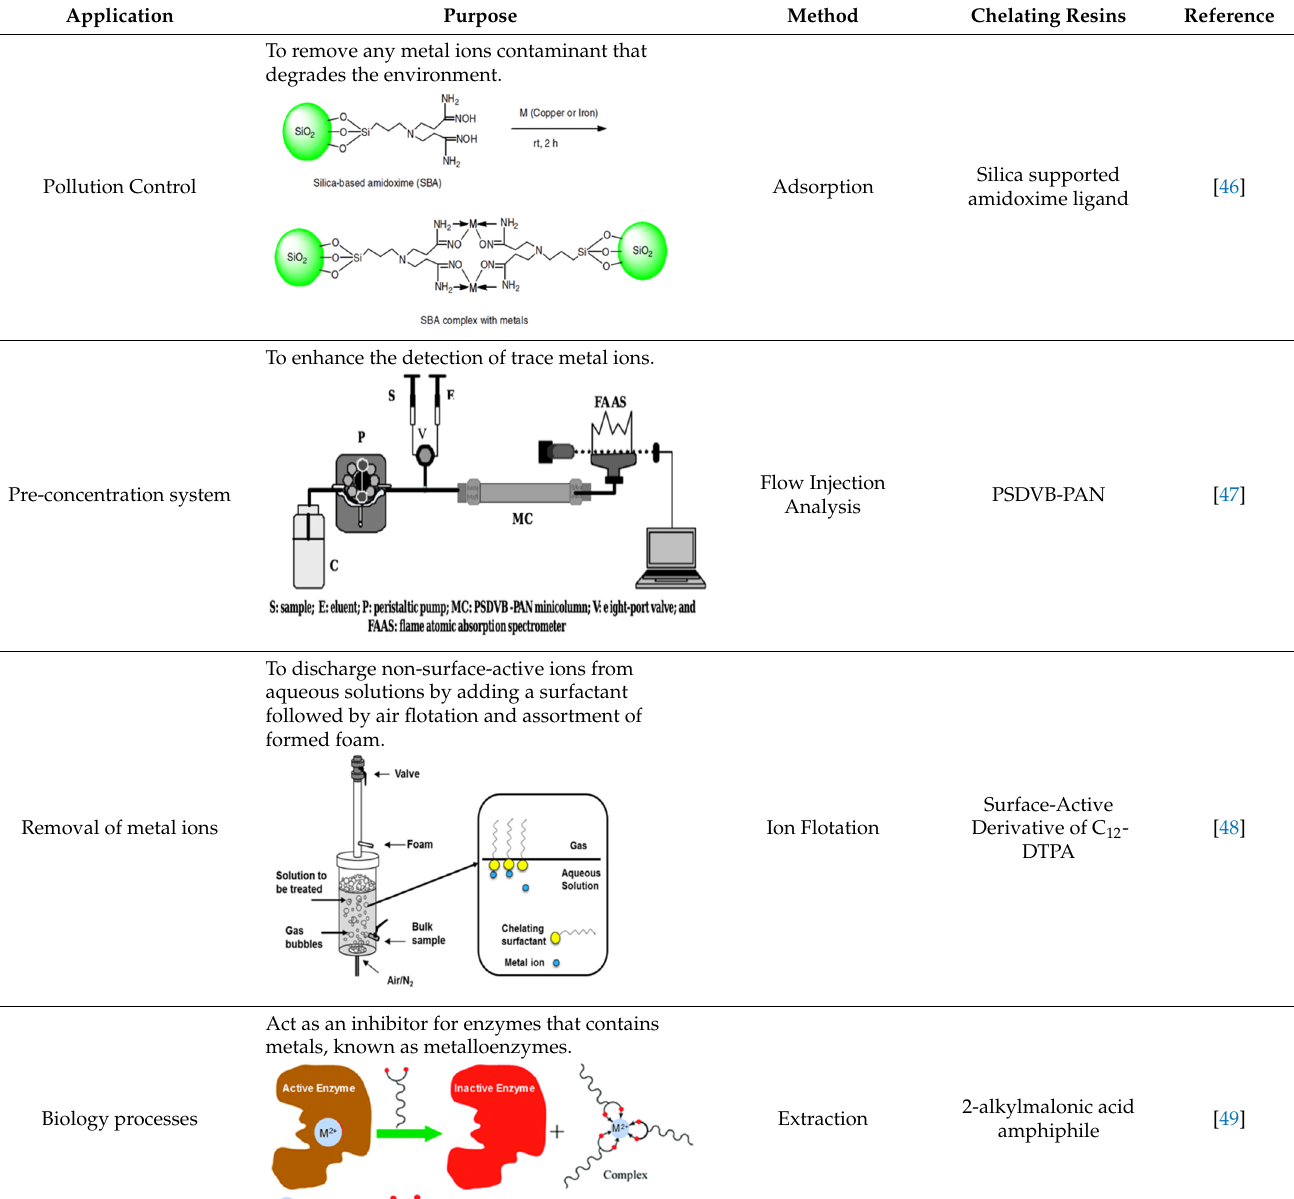
Table 8. Highlighted applications of chelating resins with their respective method and chelating resins examples. Adopted from reference [32] (copyright reserved Elsevier, 2019).